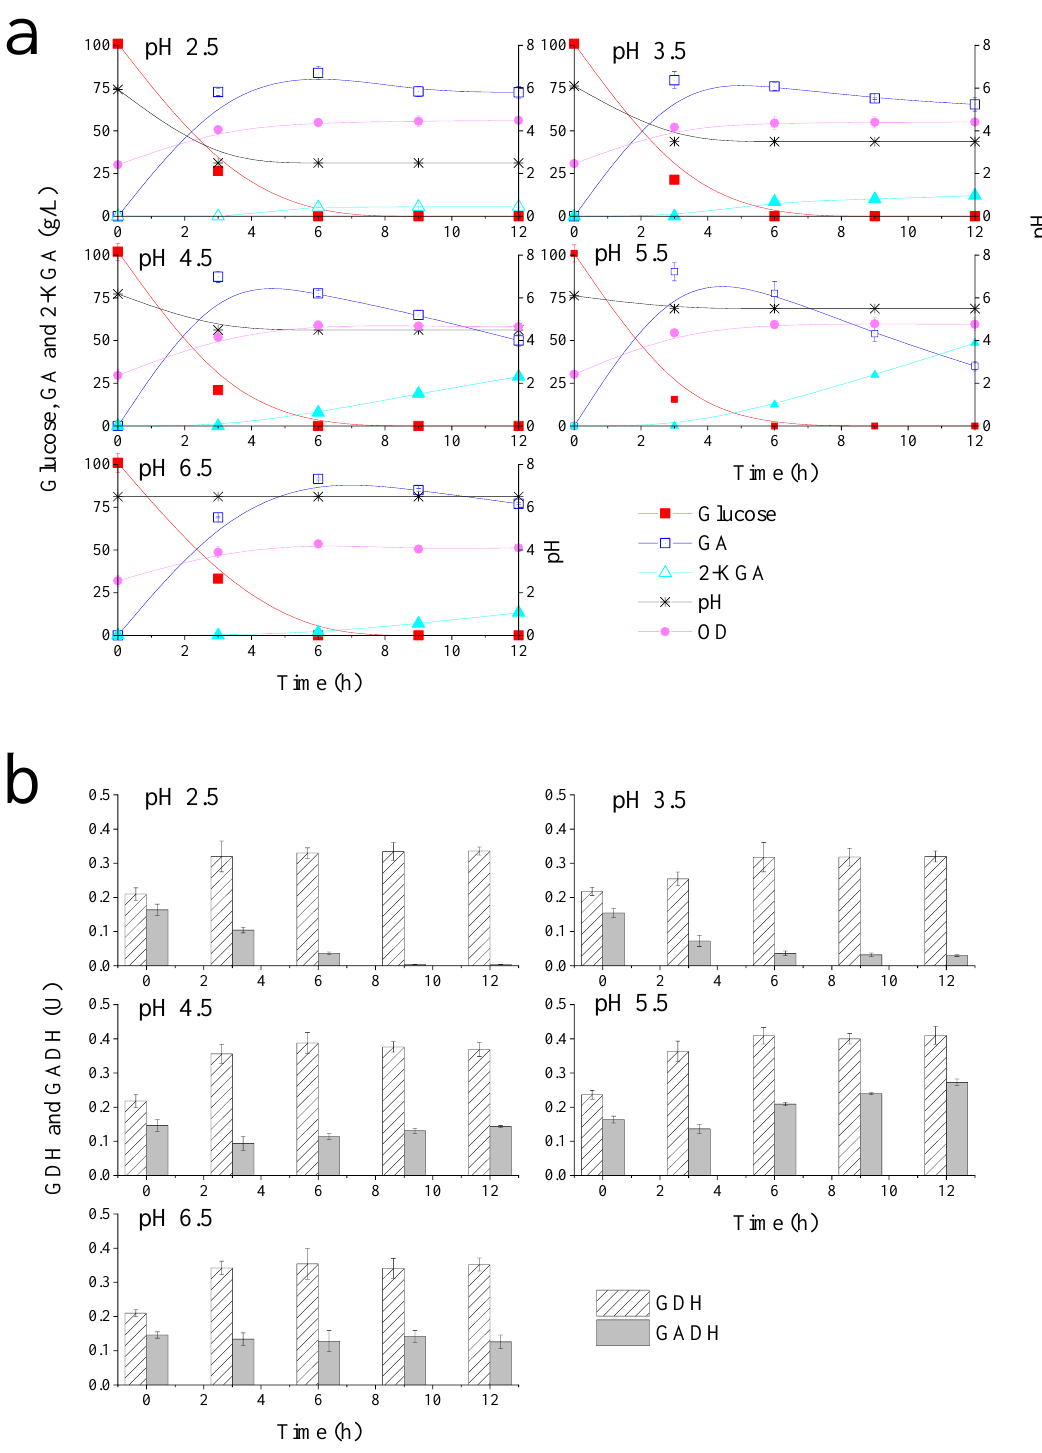
Figure 2. Gluconobacter oxydans growth kinetics, glucose metabolism kinetics (GA: gluconic acid; 2-KGA: 2-ketogluconic acid) on cell membrane ( a ); GDH (glucose dehydrogenase) and GADH (gluconic acid dehydrogenase) enzyme activities ( b ) at pH 2.5 – 6.5.